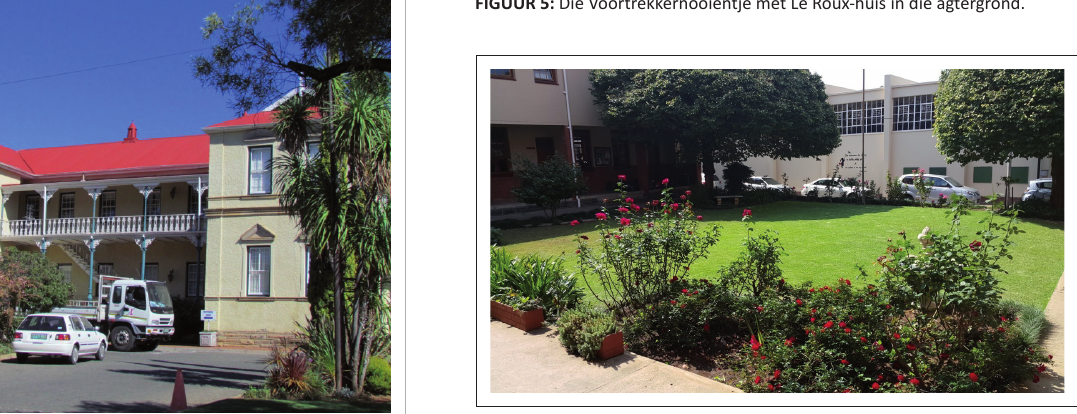
FIGUUR 4: Le Roux-huis, wat as koshuis en personeelkamer vir die primêre skool dien.